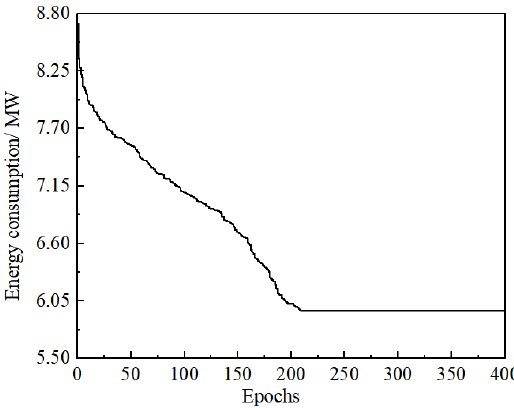
Figure 10. Result of process energy optimization.